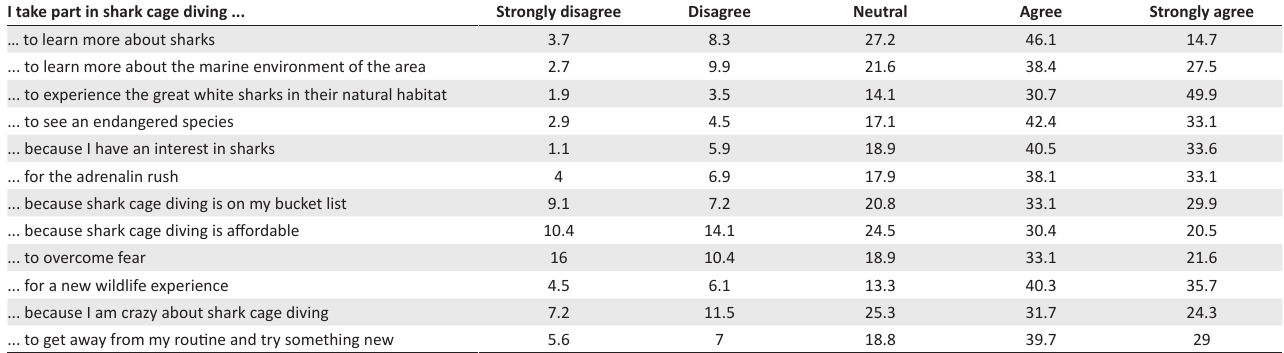
TABLE 4: Reasons why visitors take part in shark cage diving (in % ). I take part in shark cage diving ...